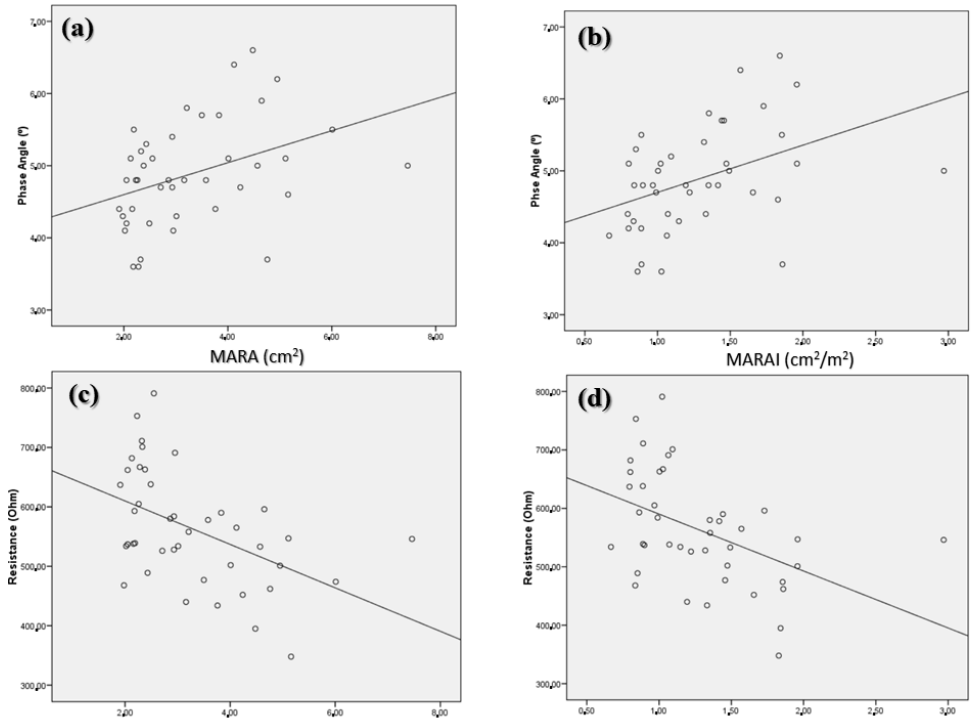
Figure 3. Correlation between phase angle ( a , b ) and electrical resistance ( c , d ) with MARA ( a , c ) and MARAI ( b , d ). MARA: muscular area rectus anterior, MARAI: muscular area rectus anterior index. A correlation of the FFMI with the muscle area (r = 0.48; p < 0.001) (Figure 4a) and circumference (r = 0.45; p < 0.001) (Figure 4b) measured by ultrasonography was observed.